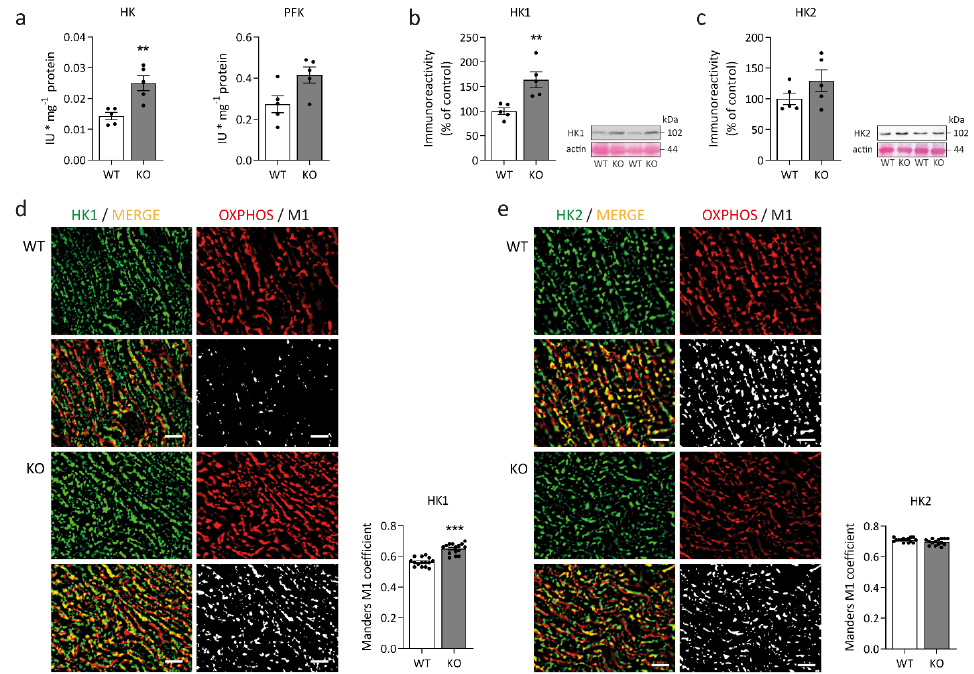
Figure 4. Activities, protein levels, and localization of glucose metabolism rate-limiting enzymes in desmin knock-out cardiac tissue. ( a ) Spectrophotometrically-determined enzyme activities of hexokinase (HK), which was significantly elevated, and phosphofructokinase (PFK) in desmin knock-out mice (KO) and their wild-type siblings (WT). For both analyses, left ventricular cardiac tissue homogenates from five animals per genotype were analyzed in duplicate; Mann-Whitney test, ** p < 0.01). ( b , c ) Further immunoblot analysis addressing hexokinase isoforms 1 (HK1) and 2 (HK2) protein levels in the homogenates revealed a statistically significant increase in the HK1 amount. For both HK1 and HK2 homogenates from five animals per genotype were analyzed in quadruplicate (HK1) or triplicate (HK2); Mann-Whitney test, ** p < 0.01. Representative immunoblots and Ponceau S-stained membranes are shown. The apparent molecular weight of HK1 and HK2 is 102 kDa. ( d , e ) The subcellular localization of HK1 and HK2 (green) in relation to mitochondrial OXPHOS components (red) was visualized in longitudinally oriented cardiomyocytes. The additional black and white images illustrate pixels of colocalization (white). Scale bars, 5 µ m. Quantitative analysis based on the Manders M1 coefficient determined an increased degree of colocalization of HK1 with the mitochondrial compartment in desmin knock-out mice (five images of different regions of cardiac muscle tissue specimens from each of the three animals of each genotype were analyzed; Mann-Whitney test, *** p < 0.001), while analysis of HK2 did not show any difference. Values in ( a – e ) are given as mean ±